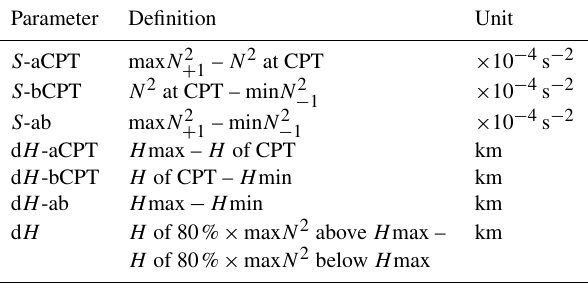
Table 2. Definitions of TIL sharpness and